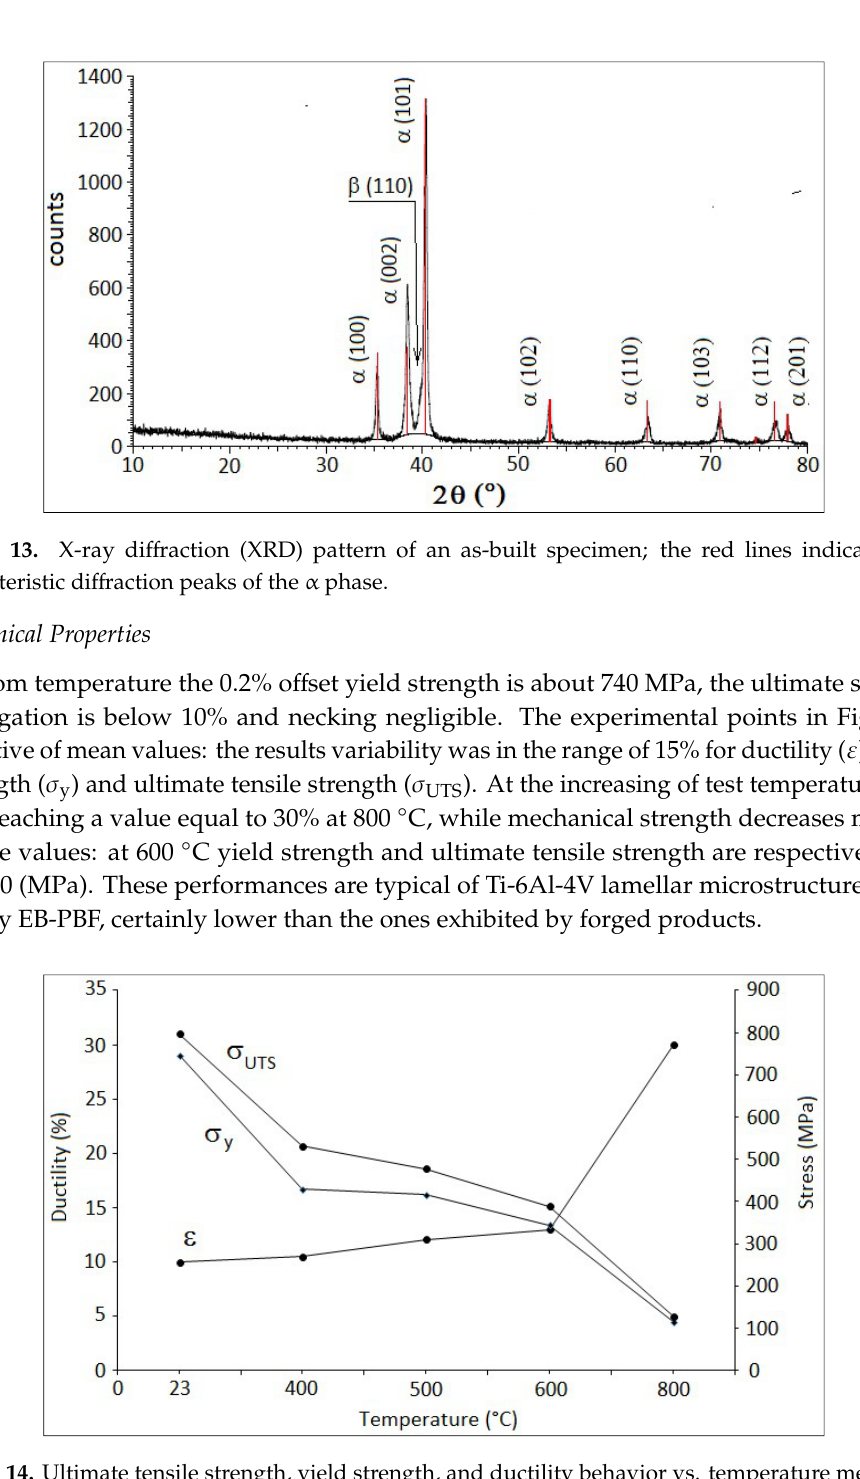
Figure 12. Optical micrographs of specimen B cross section after hot isostatic pressing (HIP).